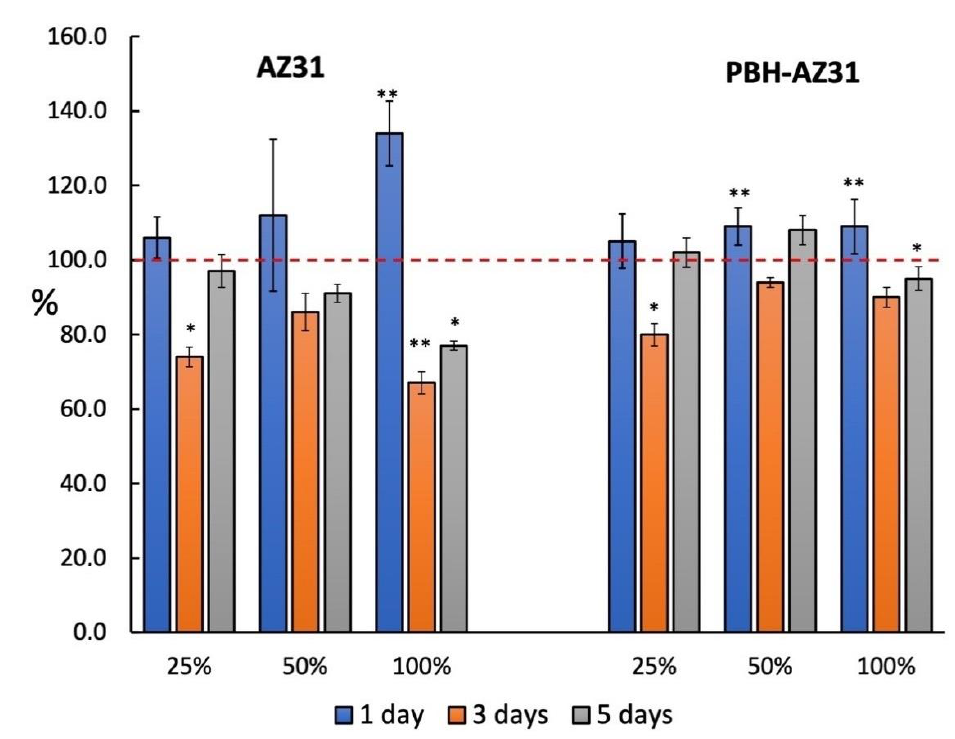
Figure 5. Proliferation of HUVECs cultured on extraction fluids after 1, 3, and 5 days. Data are reported as % of viability in standard control fluid. * Significant difference ( p < 0.05); ** highly significant difference ( p < 0.01).